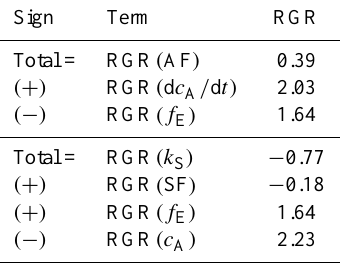
Table 3. Relative growth rates RGR ( AF ) and RGR (k S ) over 1959.0–2013.0, with the contributions from the terms in Eqs. (11) and (12), respectively. All growth rates are evaluated with Eq. (A1) and annual data to ensure that the product and quotient rules in Eq. (A3) are satisfied